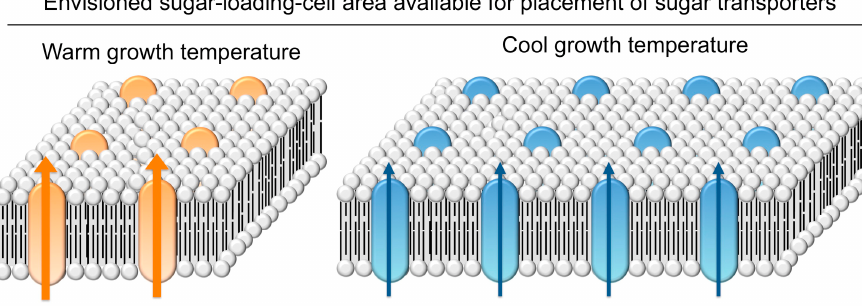
Figure 8. Schematic depiction of an increased membrane surface area of sugar-loading phloem cells, with a greater number of sugar transporters and ATPases that can counteract the reduced activity of such transporters (indicated by arrow width) in winter annual apoplastic loaders at cool versus warm growth temperatures. Based on data from Adams et al. [75] and [103].